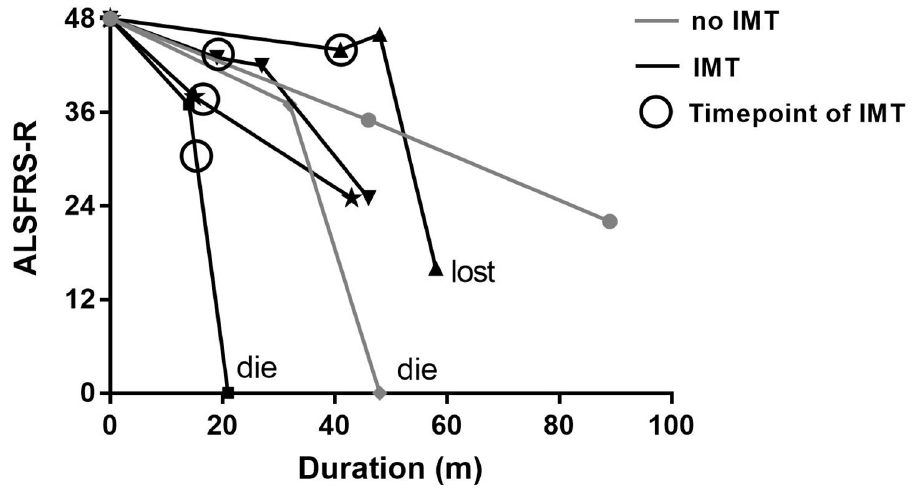
treatment in 2 patients. The slope of decreased ALSFRS-R score increased in patients not treated with immunotherapy (gray line). ALSFRS-R, revised ALS functional rating scale; IMT,